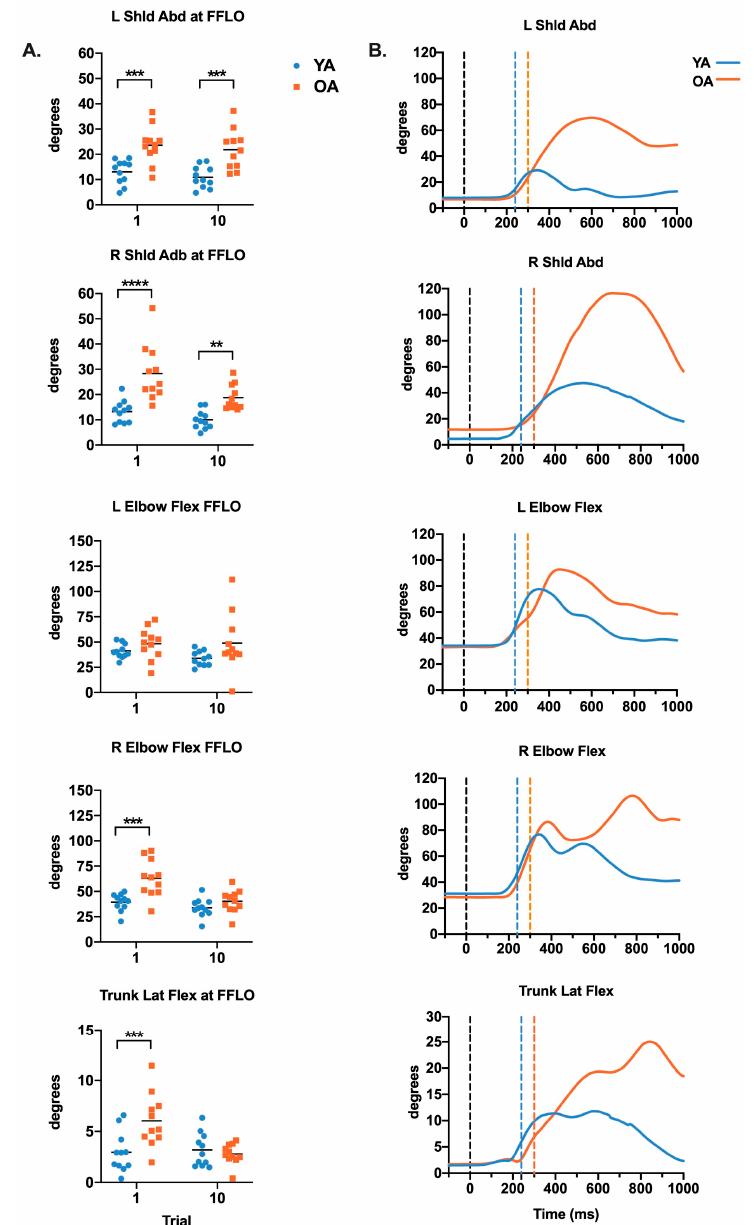
Figure 2. ( A ) Age-related di ff erences in displacement of shoulder abduction, elbow flexion, and left lateral trunk flexion at first foot lift o ff (FFLO) in trial 1 and 10. Values in scatterplots in the left column are expressed as the mean (horizontal lines) and individual data points. Corrected p -values depict di ff erences between young and older adults, ** p < 0.01, *** p < 0.001, and **** p < 0.0001. ( B ) Joint angle vs. time curves for a representative young and older adult. The black vertical line depicts the onset time of platform perturbation and the time of FFLO is labeled using a blue vertical line for young adults and an orange vertical line for older